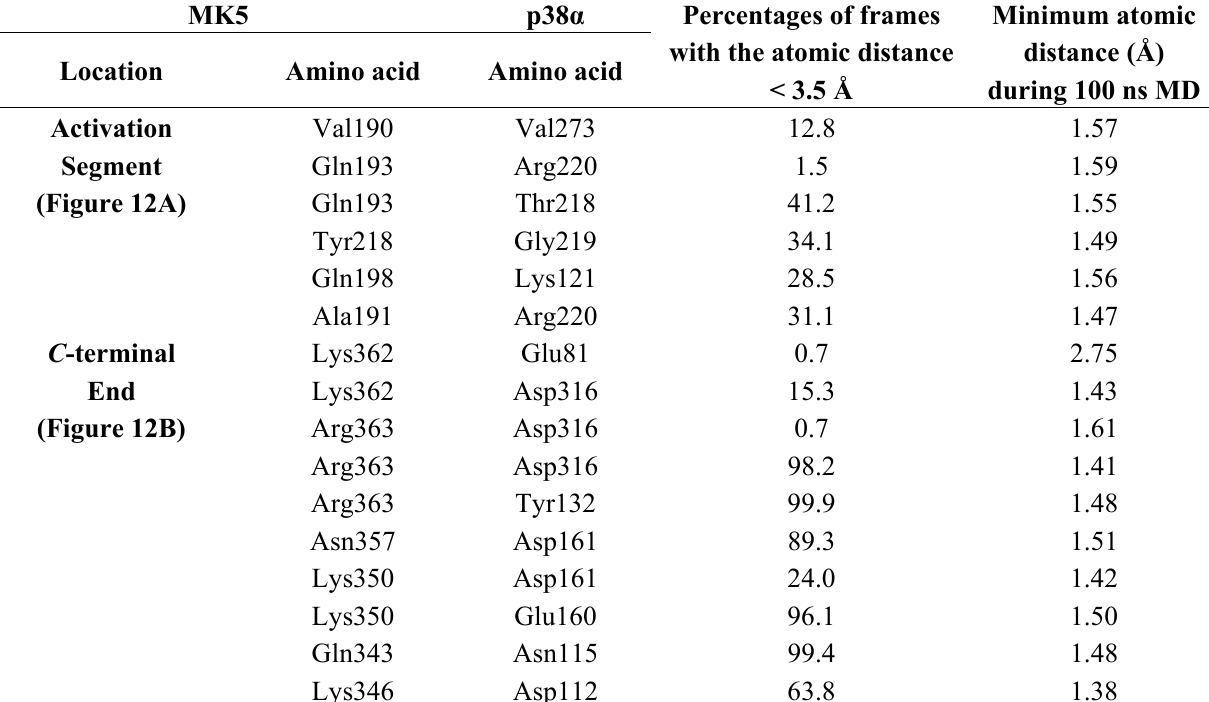
Table 1. Interacting pair of amino acids forming at the MK5-p38 α interface during 100 ns